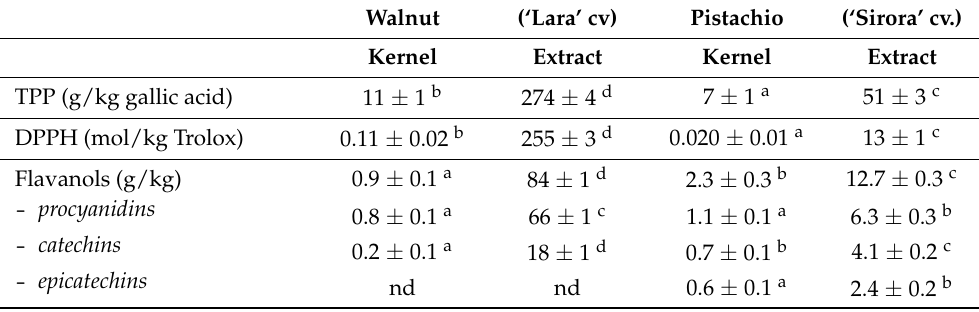
Table 1. Total polar phenolic (TPP) content, antioxidant activity (DPPH) and main individual phenolic families’ contents * in walnut (‘Lara’ cv.) and pistachio (‘Sirora’ cv.) nut kernels and their corresponding lyophilized phenolic-rich extracts ( n = 3). Walnut (‘Lara’ cv) Pistachio (‘Sirora’